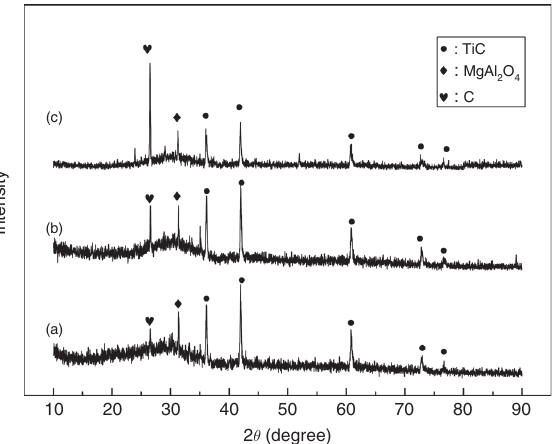
Figure 8: The percentage of total mass loss with carbon ratio of 1.0 at different